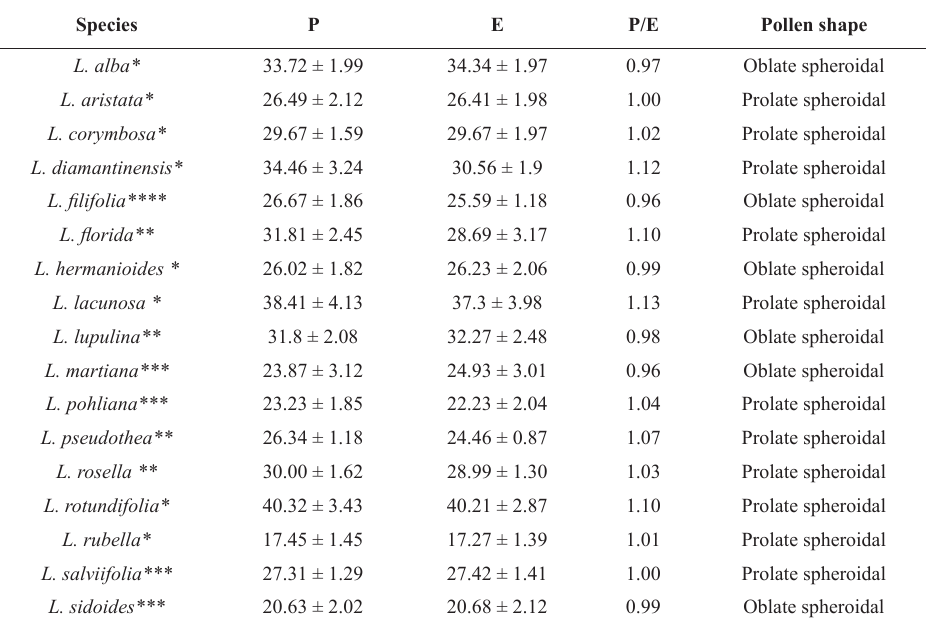
Pollen morphological data (mean values and standard deviations in μm) of Lippia species. E = equatorial diameter, P = polar